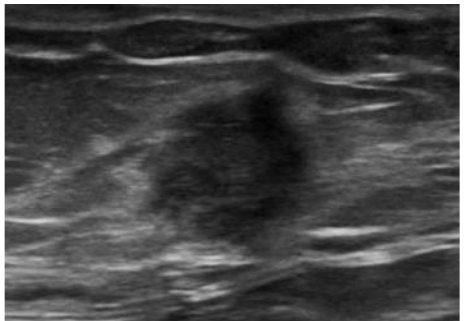
Figure 17. Endometrioma of the abdominal wall on US: heterogeneously hypoechoic, round, or oval-shaped nodule, with scattered internal echoes. CT shows solid masses with ill-defined borders, isoattenuating to the surrounding muscles [55]. After contrast injection, endometriosis may show slight enhancement [50,53, 54] and a characteristic “Gorgon sign”, corresponding to linear strands irradiating peripherally from the central nodules [55]. MRI provides excellent contrast resolution and